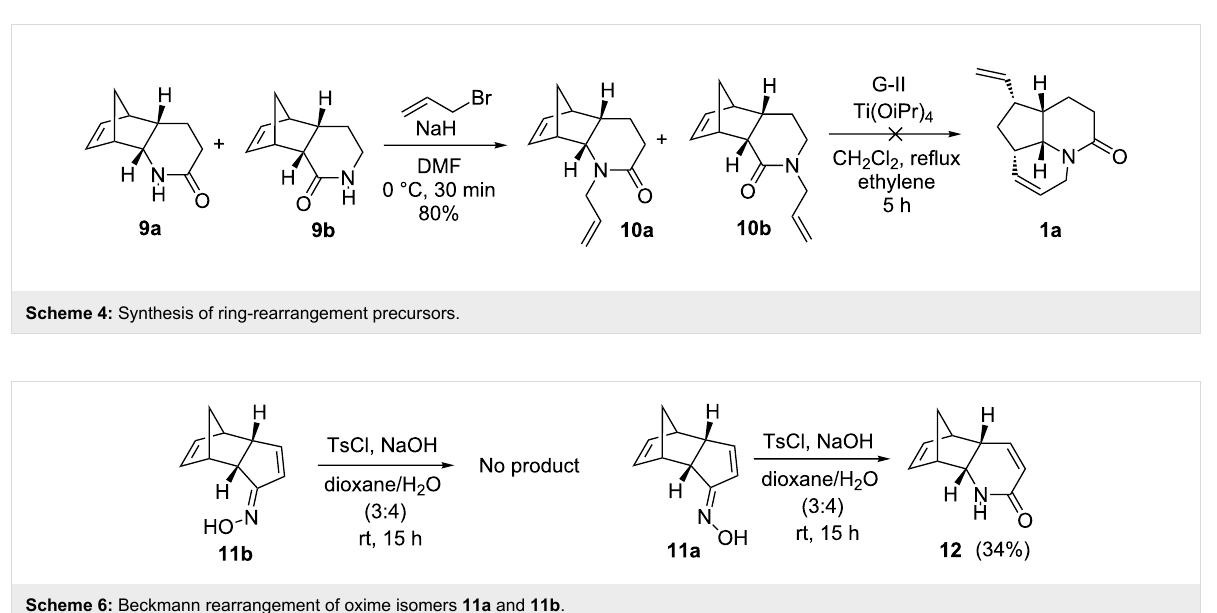
Scheme 6: Beckmann rearrangement of oxime isomers 11a and 11b .